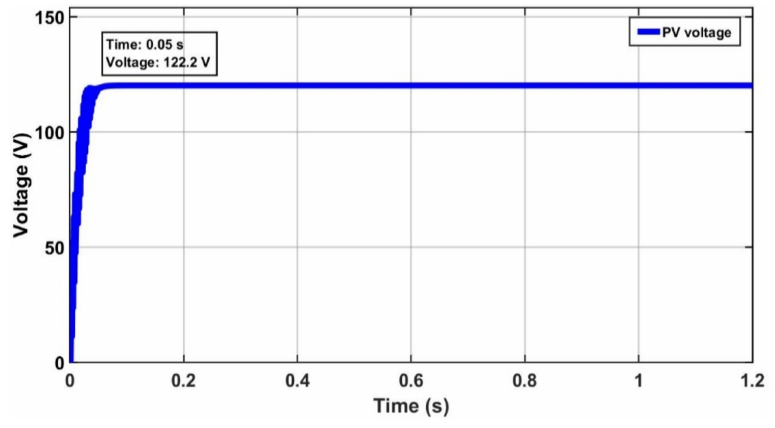
Figure 22. V pv of Firefly Algorithm (Case-1).